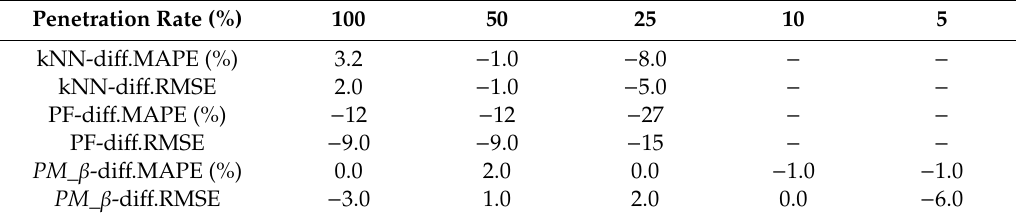
Table 3. Accuracy for comparison methods under di ff erent penetration